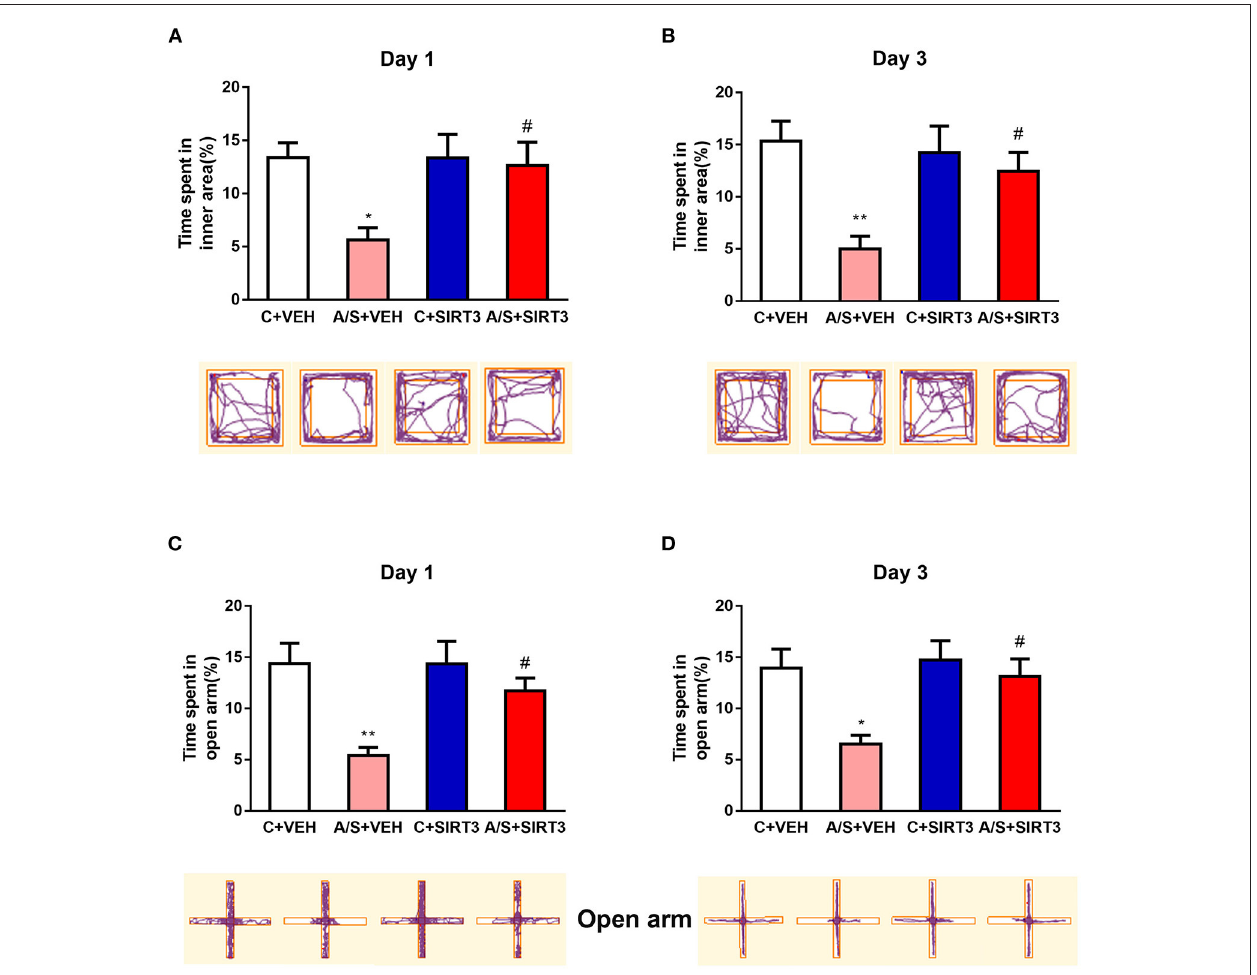
FIGURE 1 | Effect of SIRT3 effect on anxiety-like behavior induced by anesthesia/surgery. (A,B) The percent time spent in inner area and movement trace of the OFT among the 4 groups. (C,D) The percent time in open arm and movement trace of the EPM among the 4 groups ( n = 10 per group, * p < 0.05; ** p < 0.01). Data are presented as the means ±